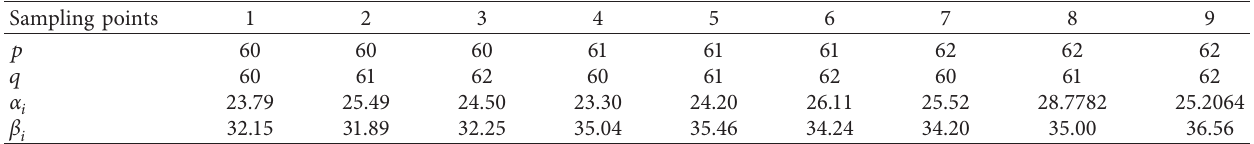
Table 4: Polarization state in the region of null concave.